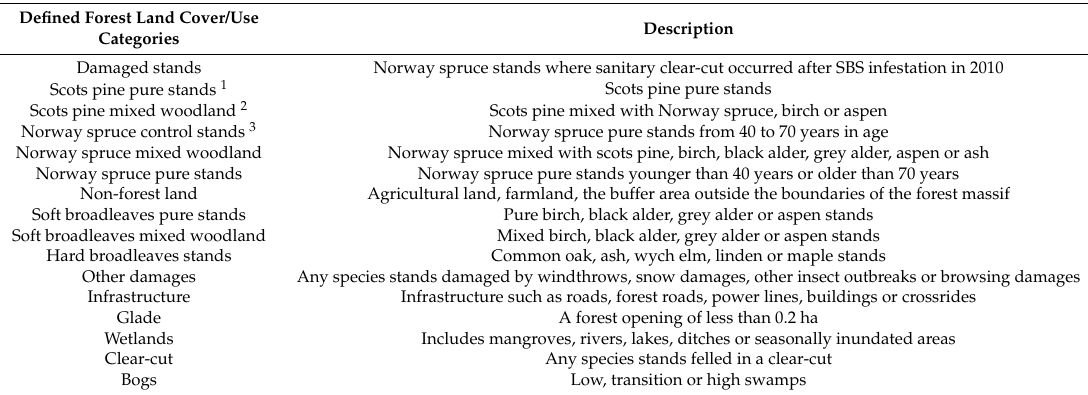
Table 1. List of the forest land cover/use classification